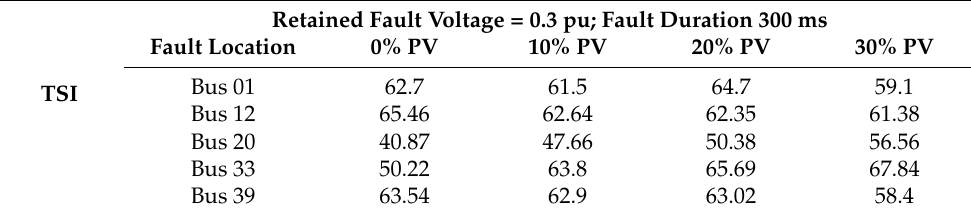
Table 2. TSI values for different solar PV penetration